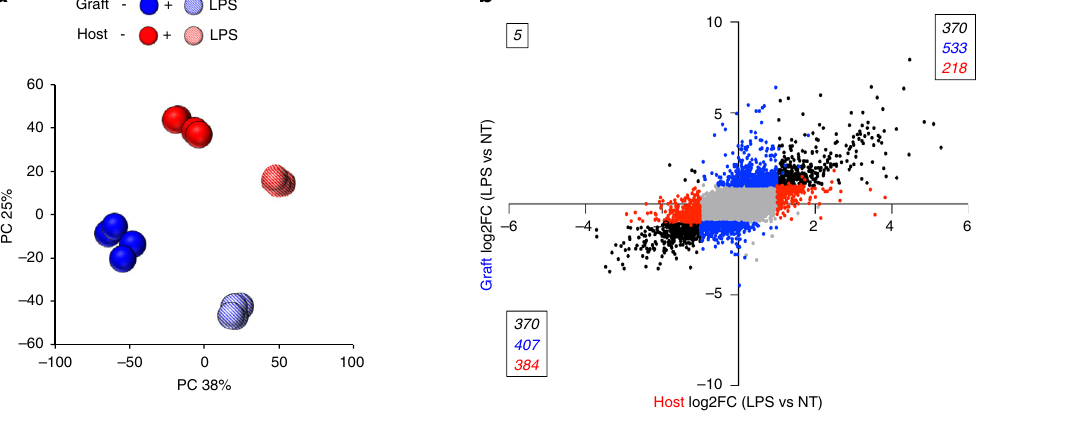
(Supplementary Table 1). Engrafted macrophages displayed for instance activation of pathways controlled by IL1b and Ifng and suppressed by IL-10.